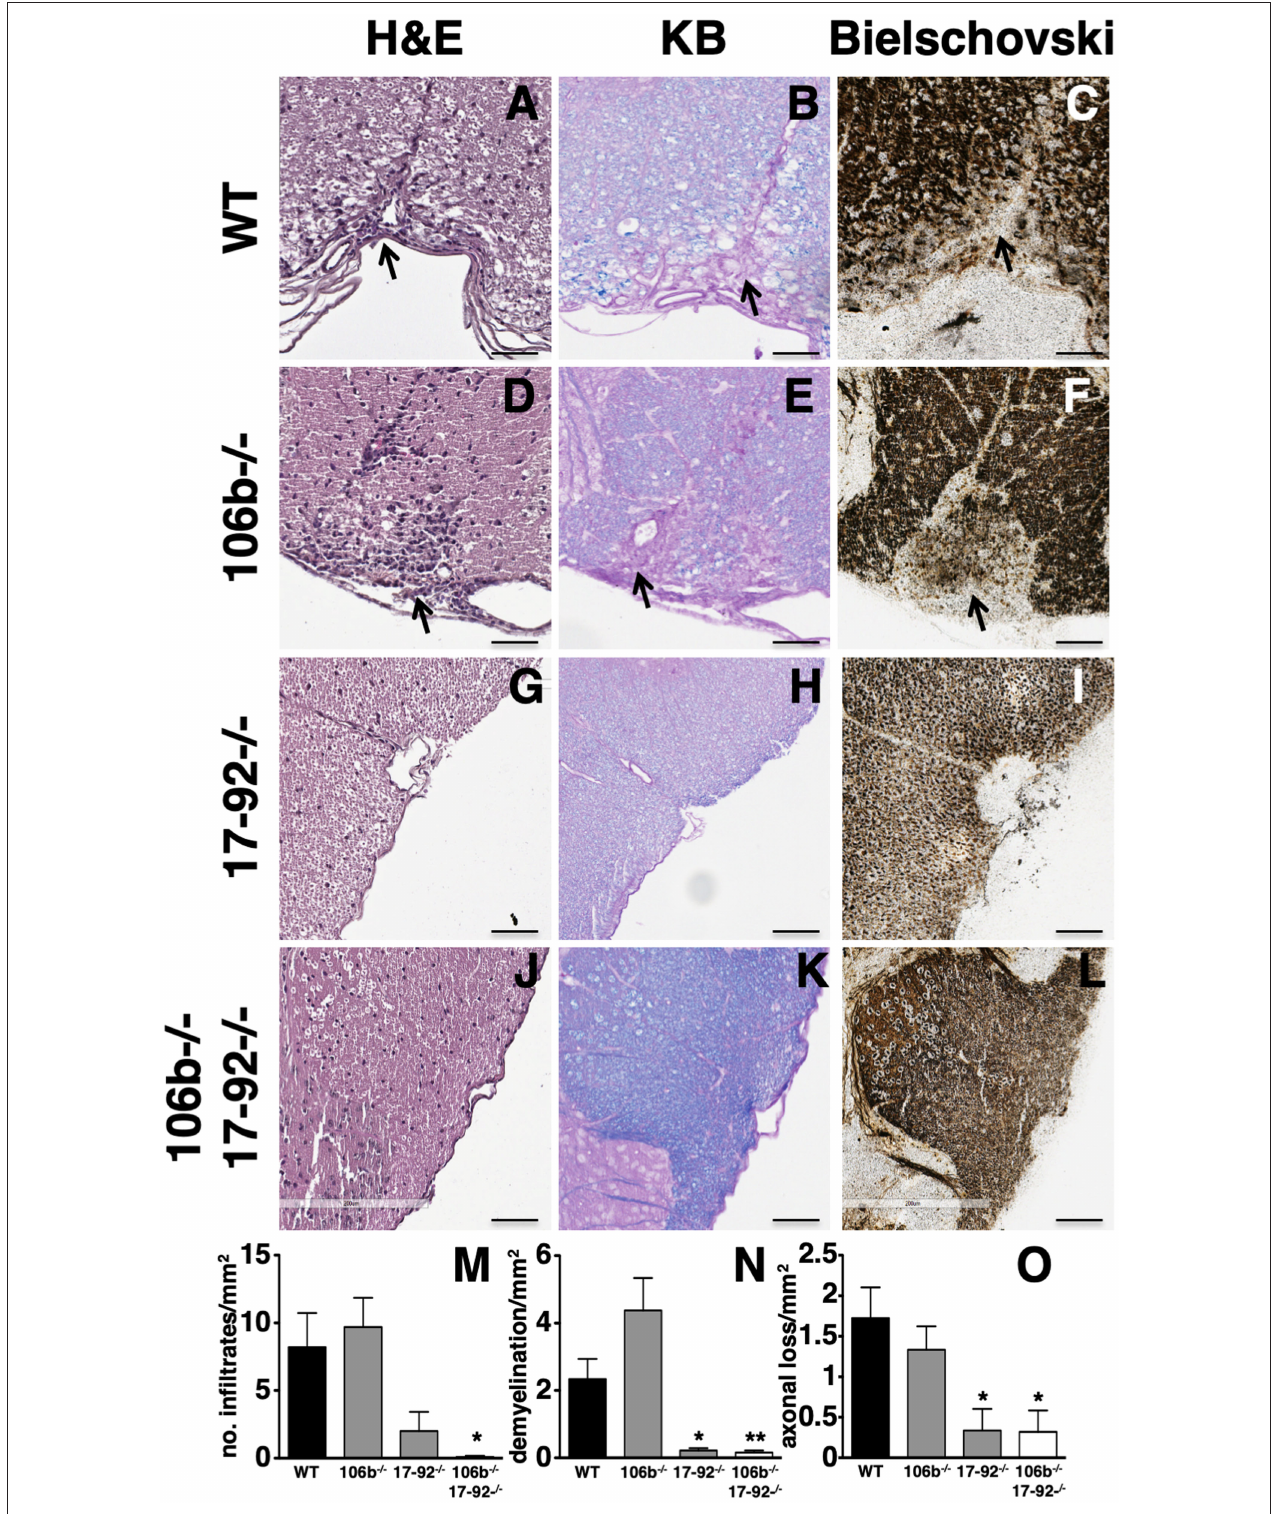
FIGURE 3 | Lack of miR17-92 or both miR17-92 and miR106b protects mice from pathological signs of EAE. Neuropathological analysis of infiltrates (Hematoxylin and Eosin; A,D,G,J ), demyelination (Kluver Barrera; B,E,H,K ), and axonal loss (Bielschowsky; C,F,I,L ) in the spinal cord. Scale bar = 100 µ m. Deletion of miR17-92 or both miR17-92 and miR106b is associated to a significant decrease of number of infiltrates (M) , demyelination (N) , and axonal damage (O) . Data are shown as mean ± SEM. Statistical significance was determined by Mann Whitney test. * P ≤ 0.05 and ** P ≤ 0.01.